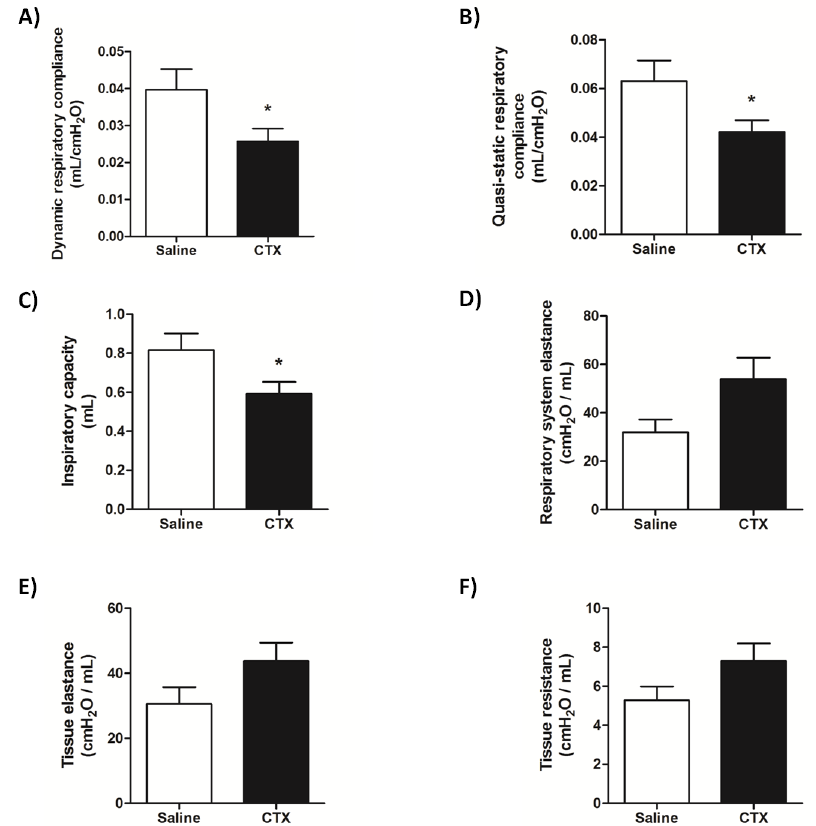
Figure 5. Lung mechanics in mice treated with CTX for 12 h. The respiratory mechanics parameters ( A ) Dynamic respiratory compliance, ( B ) Quasi-static respiratory compliance, ( C ) Inspiratory capacity, ( D ) Respiratory system elastance, ( E ) Tissue elastance, and ( F ) Tissue resistance were measured in vivo using a small animal ventilator, 12 h after CTX (300 µg/Kg s.c.) or saline (control) administration. The results are representative from two independent experiments ( n = 8–10 animals/group). * P < 0.05 vs. control group —unpaired Student’s t -test.